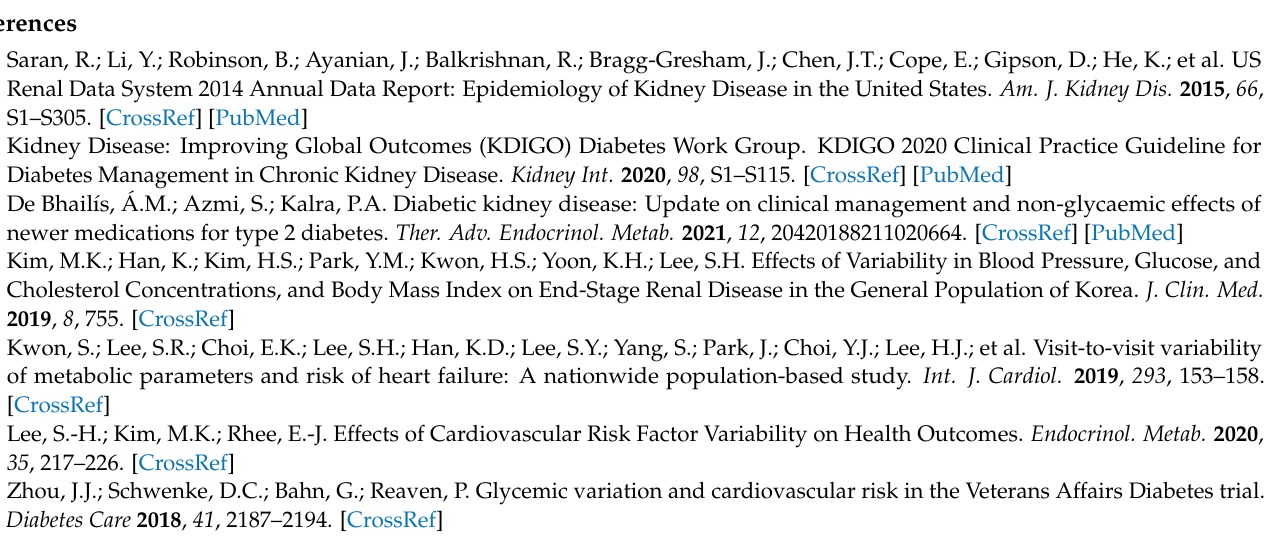
Table S1: Hazard ratios (HRs) and 95% confidence intervals (CIs) for the incidence of end-stage kidney disease by deciles of fasting glucose variability. Table S2: Hazard ratios (HRs) and 95% confidence intervals (CIs) for the incidence of end-stage kidney disease by quartiles of fasting glucose variability, assessed by standard deviation, coefficient of variation, and average real variability. Table S3: Hazard ratios and 95% confidence intervals for the incidence of end-stage of renal disease according to baseline fasting glucose